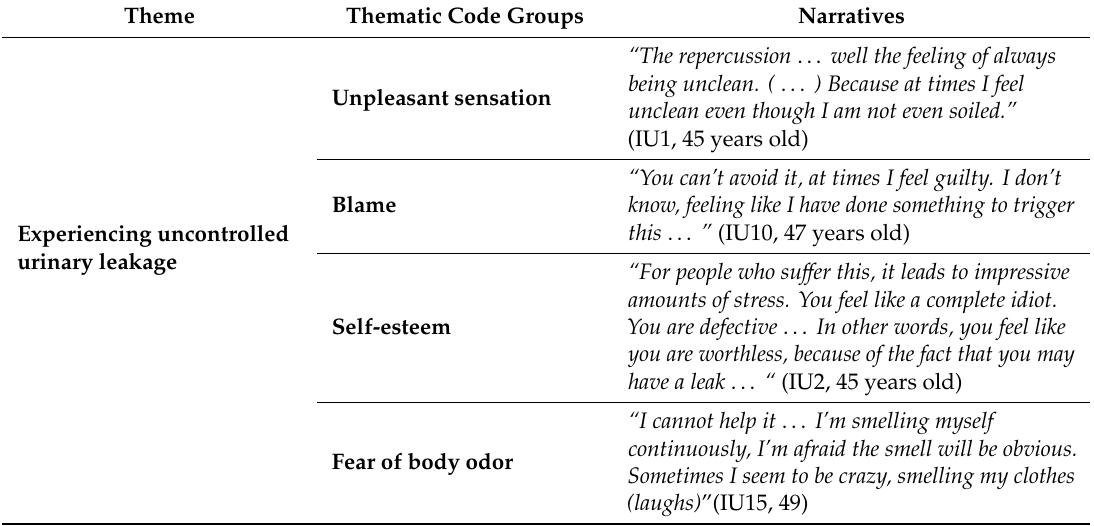
Table 3. Participants’ narratives from the theme: Experiencing uncontrolled urinary